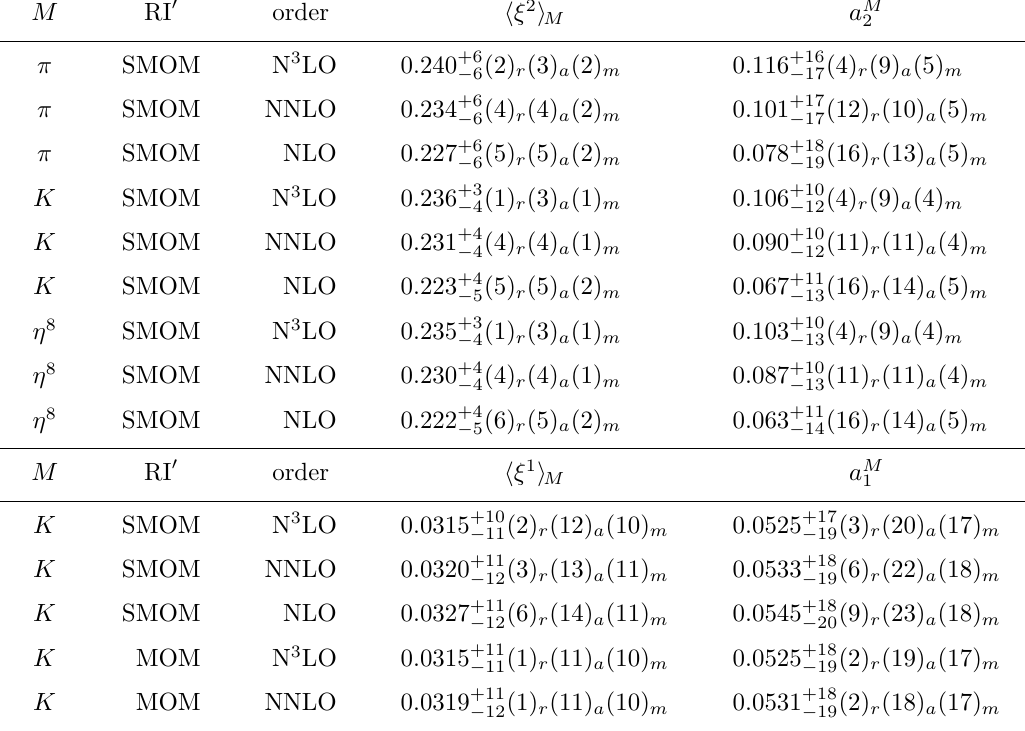
Table 1 . Continuum limit extrapolated values for the first two moments of the octet mesons. The results have been converted to the MS scheme at µ = 2 GeV using intermediate RI 0 schemes and different loop orders in the perturbative matching. The statistical error given as sub- and superscript reflects the errors of the data after extrapolation. The numbers in parentheses give estimates of the systematic uncertainties due to the nonperturbative renormalization ( r ) as described in section 2.3 of ref. [1], the continuum extrapolation ( a ), and the chiral extrapolation ( m ). As discussed in section 3.1 of ref. [1], finite volume effects are negligible in our